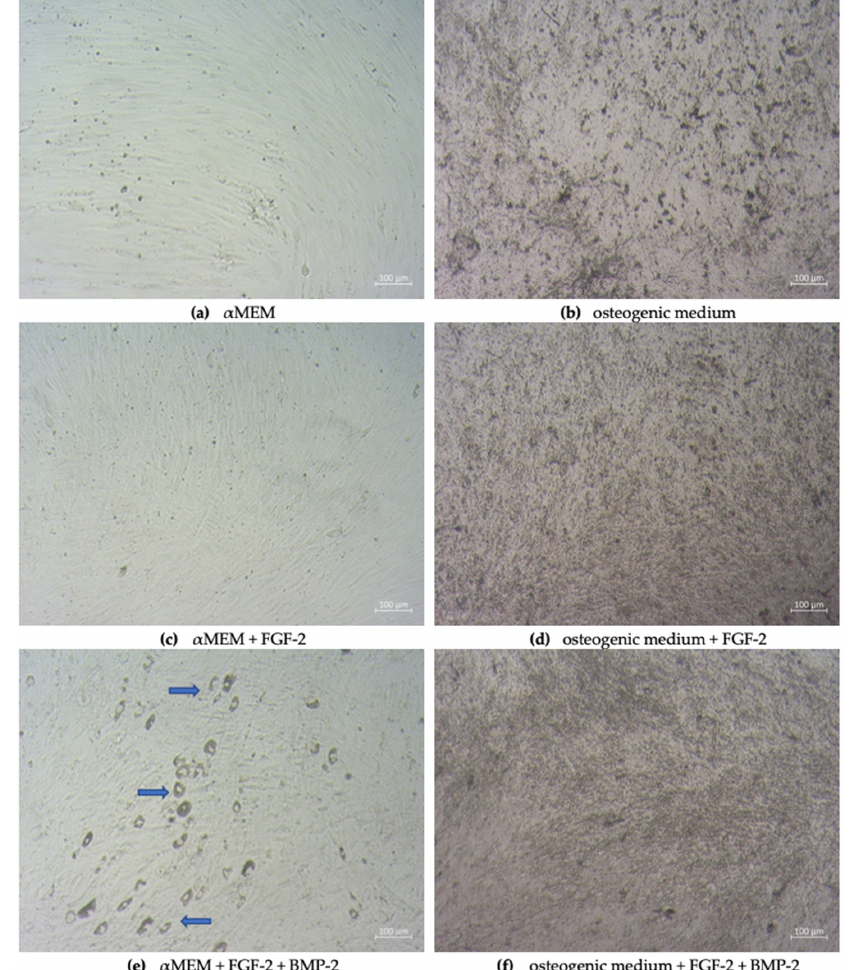
Figure 1. Morphological changes of sheep bone marrow-derived mesenchymal stem cells (BM-MSCs) in di ff erent culture conditions. BM-MSCs were cultivated in an α MEM or osteogenic di ff erentiation medium, both supplemented with or without BMP-2 and / or FGF-2 for 21 days. In response to both stimuli (FGF-2 and BMP-2), the cells exhibited di ff erent cellular morphology compared to the control culture conditions, i.e., α MEM or osteogenic di ff erentiation medium without any additional cytokines ( a , b ). Cells treated with FGF-2 were smaller and grew more densely ( c ). FGF-2 and BMP-2 added to the complete α MEM medium showed an osteogenic di ff erentiation of the cells ( e ), and when added to the osteogenic di ff erentiation medium, they altered the size and density of calcium acceleration ( d , f